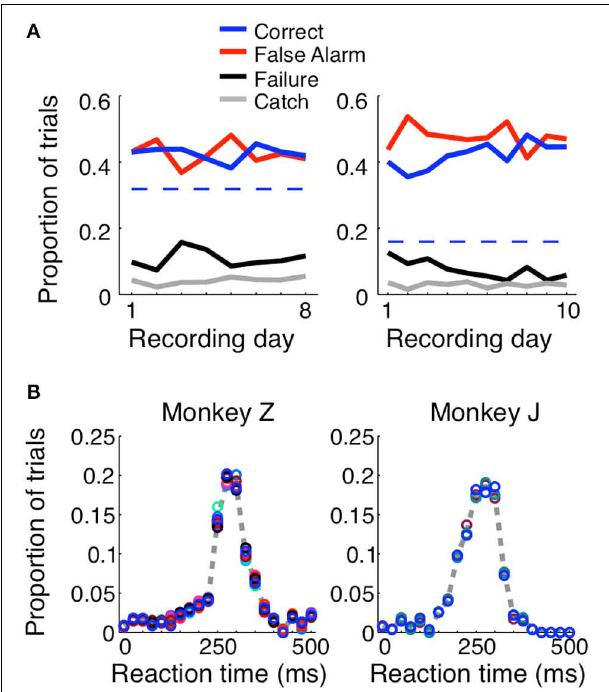
FIGURE 2 | Trial outcomes across days and reaction times for each animal. Both animals correctly detected the presence of a shape ~40–50% of the time ( A , solid blue lines). Dashed blue lines represent the percent correct that could be achieved by random guessing. False alarm trials, in which the animal incorrectly reported the presence of a shape before one appeared, were equally prevalent (red lines). The animals failed to respond to the presence of a shape ~10–20% of the time (black lines), and in ~5% of the trials, the animals remained fixated throughout the duration of a catch trial, when no shape appeared. The reaction time distributions were similar for both animals (B) and across shapes (represented by circle color). If the animals were randomly guessing, these distributions would be flat.